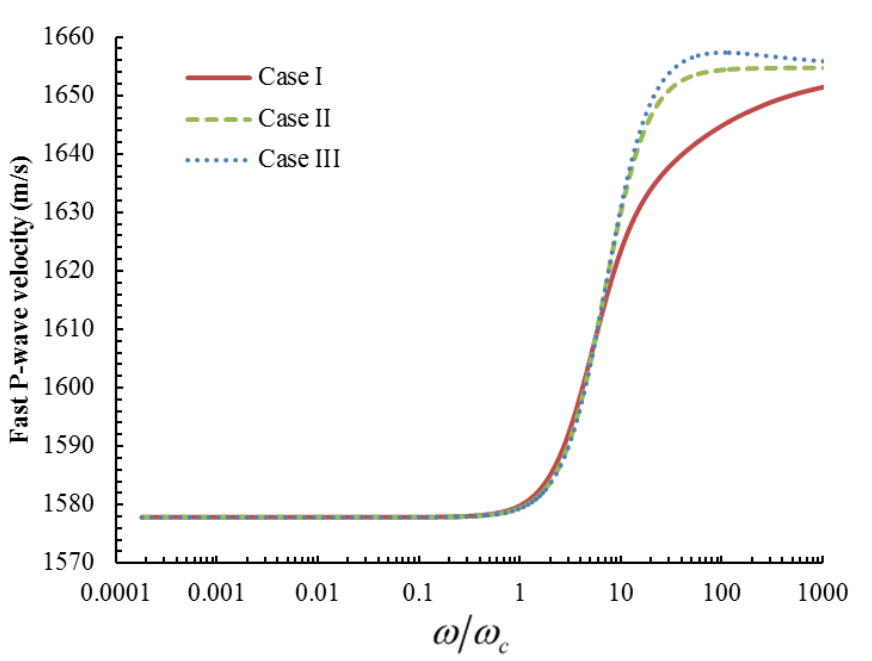
Fig. 2. Fast wave velocity versus dimensionless